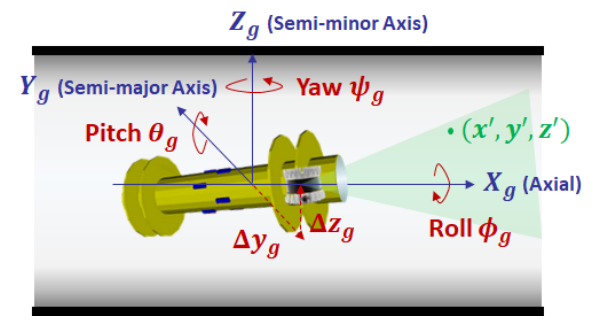
Figure 5. Geometric pipe